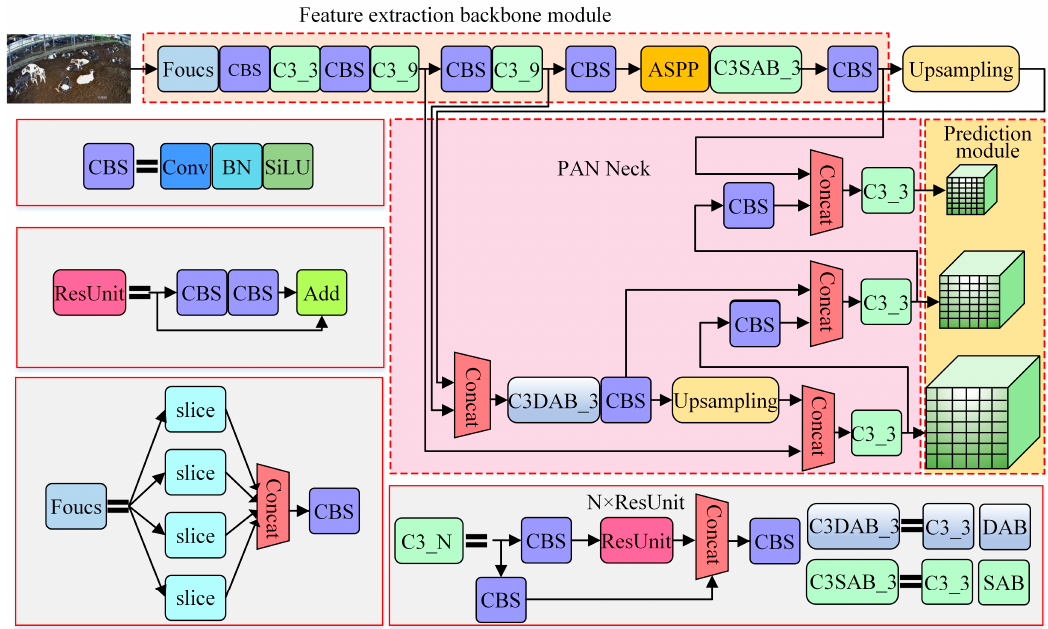
Figure 7. Overall structure of the CEBD-YOLO model.